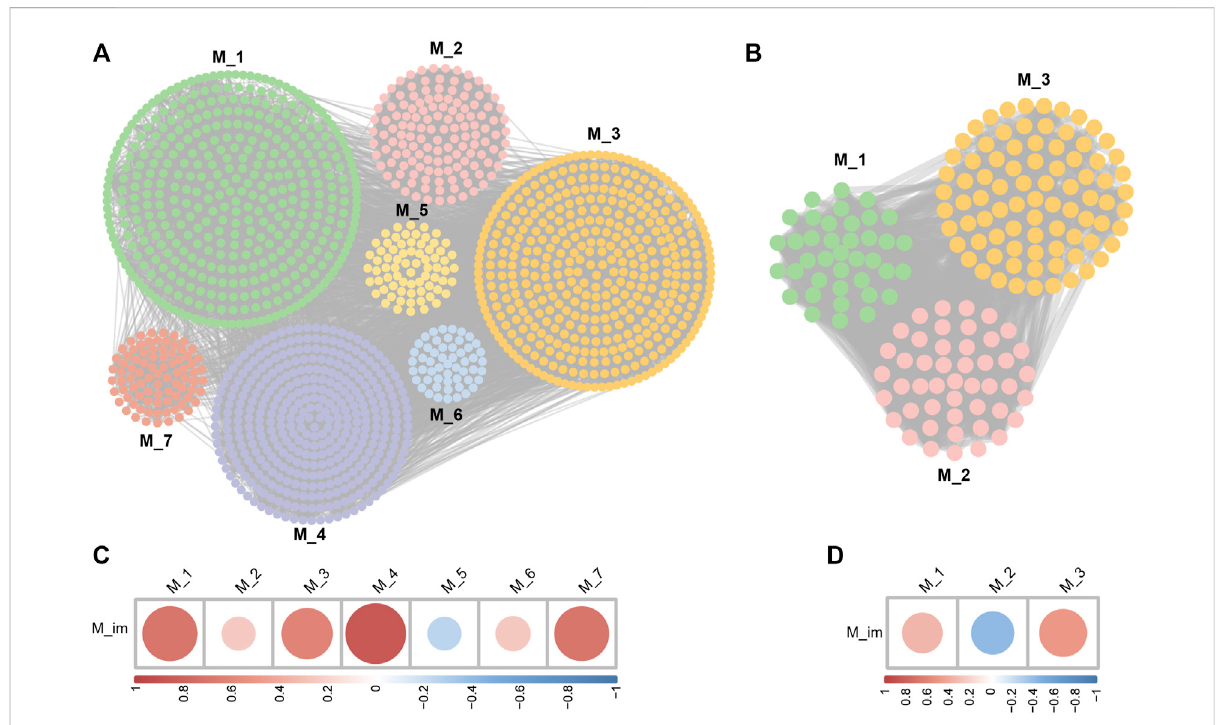
FIGURE 5 (A) The communitydiscovery clustering network ofAS; (B) The communitydiscoveryclustering network ofLBMD; (C) Correlation between the immune module and AS modules; (D) Correlation between the immune module and LBMD modules.